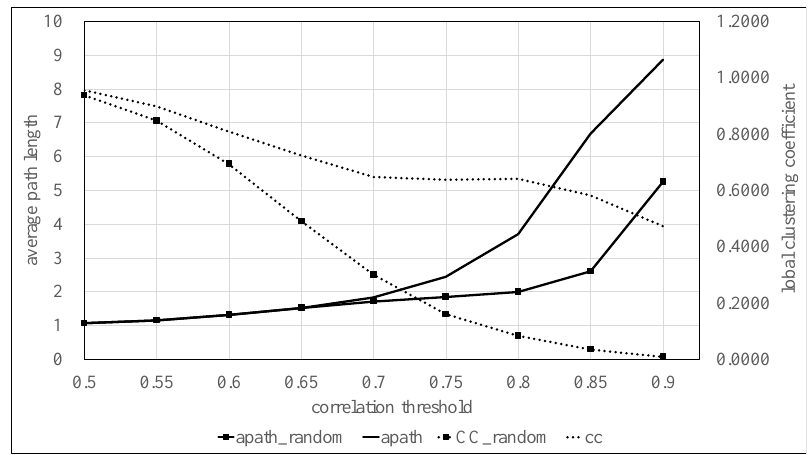
Figure 9. Comparison between the precipitation network and a random